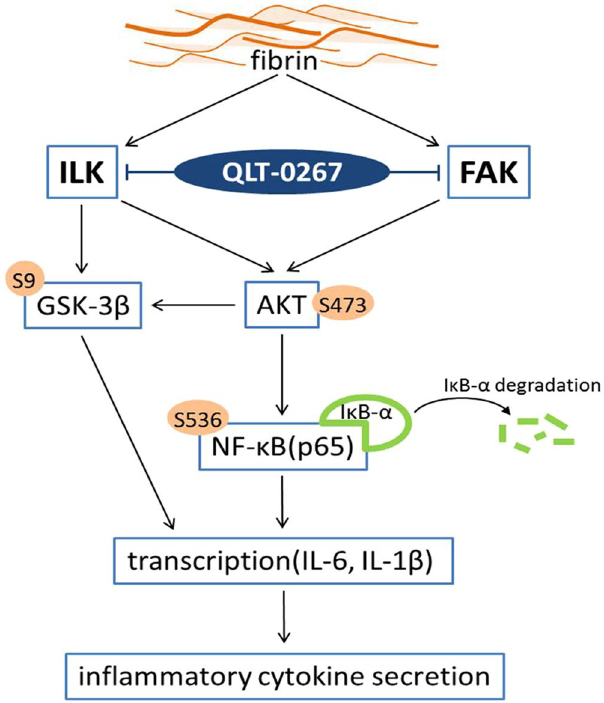
Figure 10. Diagram showing fibrin and QLT-0267 involvement in the pathogenesis of peritoneal adhesion. Peritoneal insults induce the release of inflammatory cytokines, which promotes fibrin formation. Fibrin deposition on PMCs induces cytokine production from the PMCs, which further promotes peritoneal adhesion. QLT-0267 has inhibitory effects on both the ILK and FAK